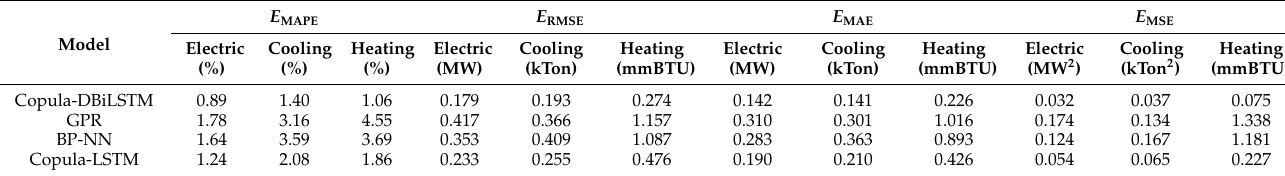
Figure 7. Comparison of results under different models. Table 3. Error comparison under different models.